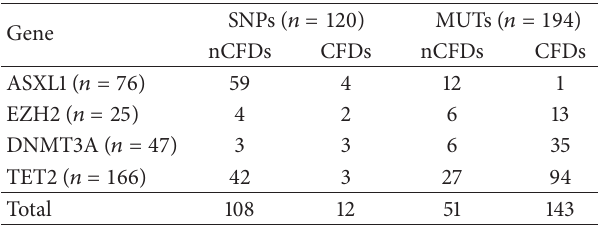
Table 3: Number of SNPs and mutations (MUTs) in the dataset. Gene